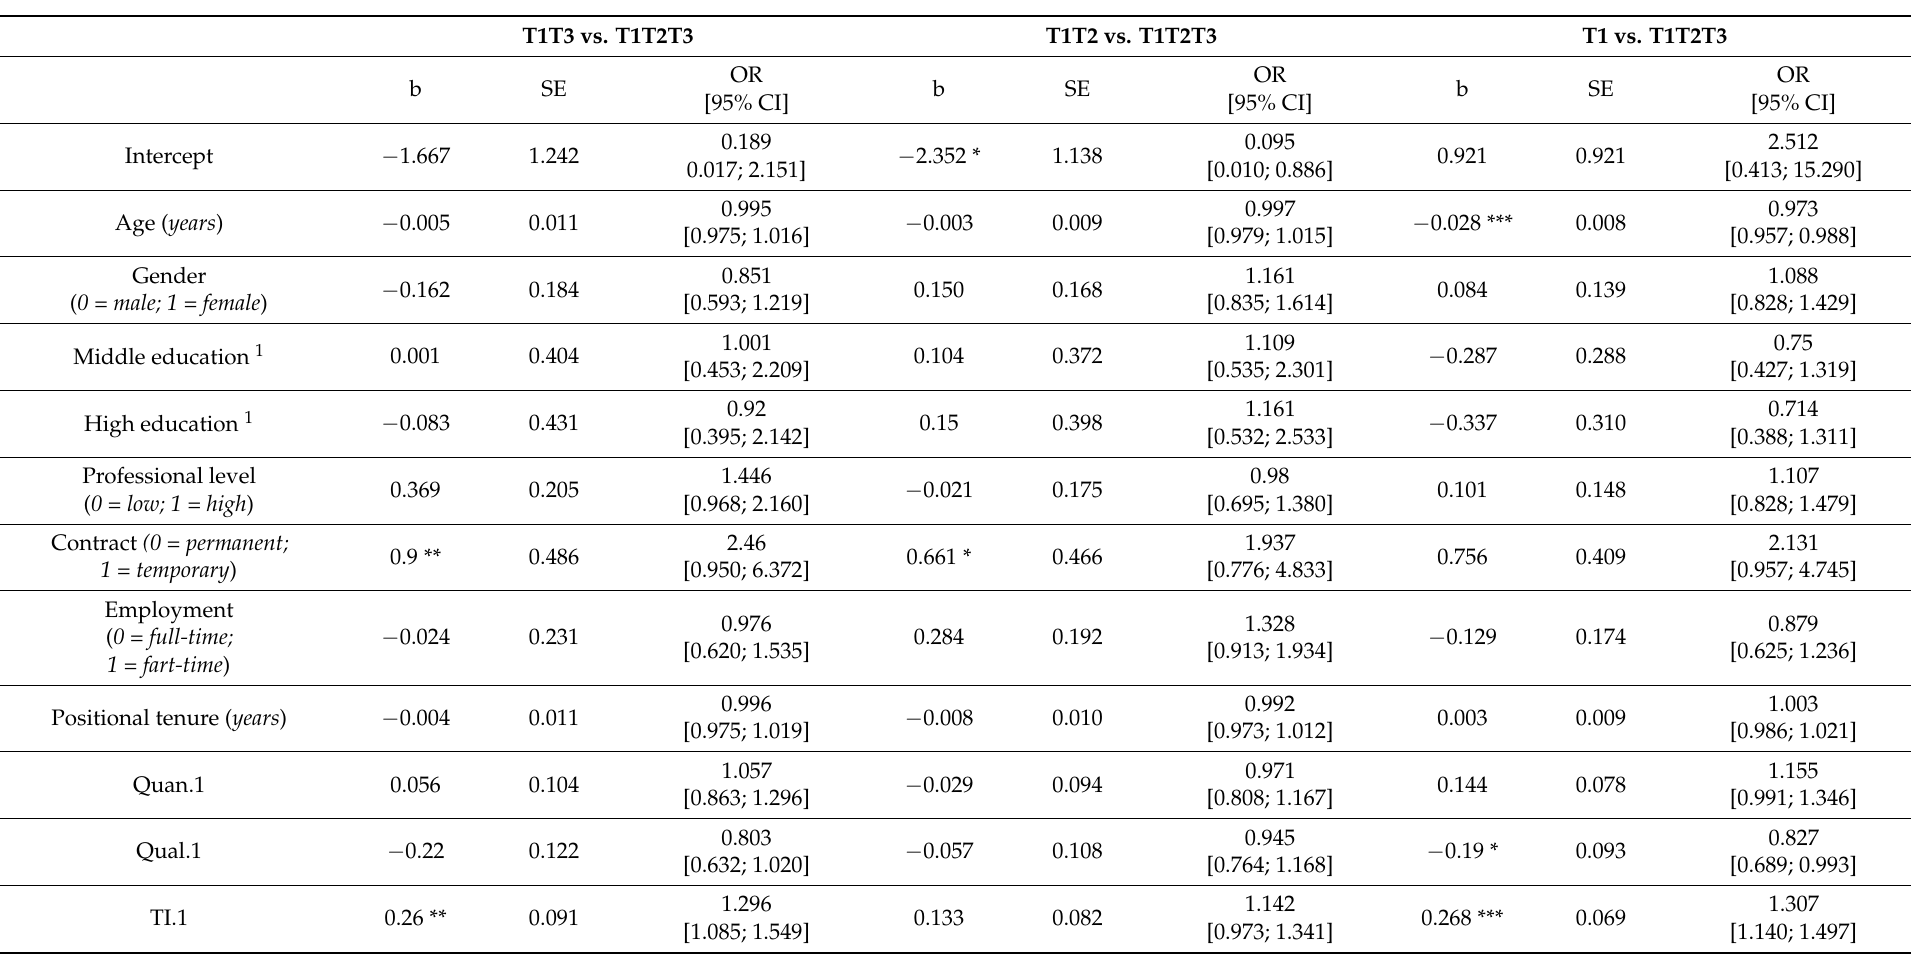
Table A1. Multinomial logistic regression of